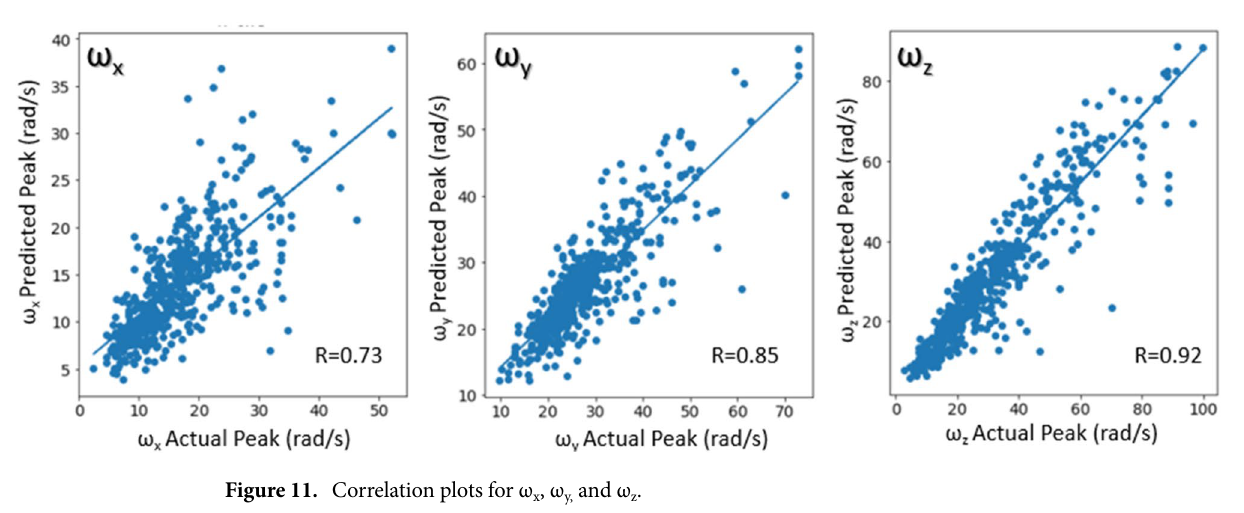
Figure 10. Actual and predicted time histories for ω z for 5 random cases from the test dataset.